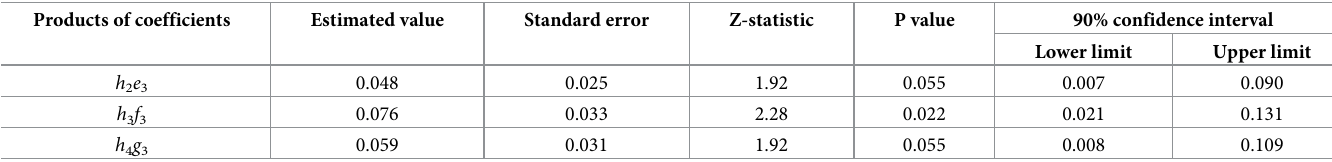
Table 7. Significance test of moderated mediation effects. Products of